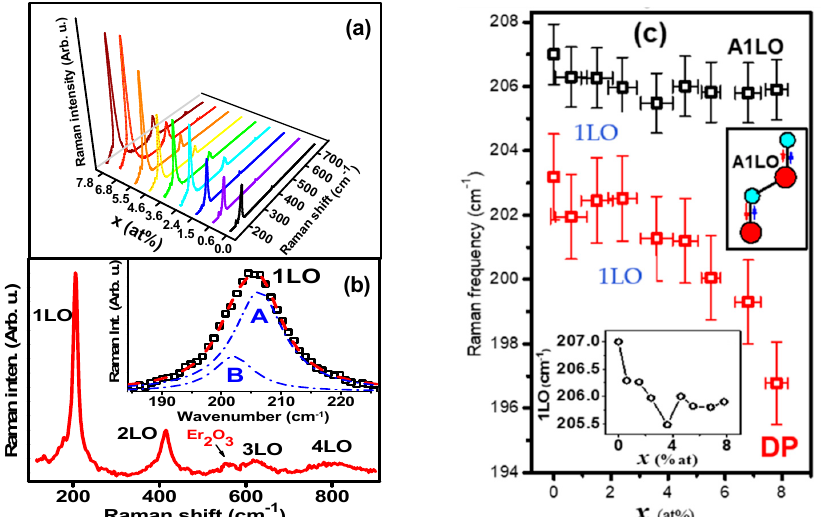
Figure 3. ( a ) Phonon Raman spectra of the series of Cd 1- x Er x Se samples. ( b ) Raman spectrum of a representative CdSe:Er sample where the 1LO phonon mode and up to the third overtone are observed, a Raman signal from Er 2 O 3 is revealed in the spectrum. The inset illustrates the deconvolution of the band at ~205 cm − 1 in the 1LO mode (A) and the surface mode (B). ( c ) The 1LO (A) and the surface (B) modes positions against x . The low inset exhibits the 1LO mode position vs. x in a magnified scale. The right inset illustrates the A1LO mode oscillation.